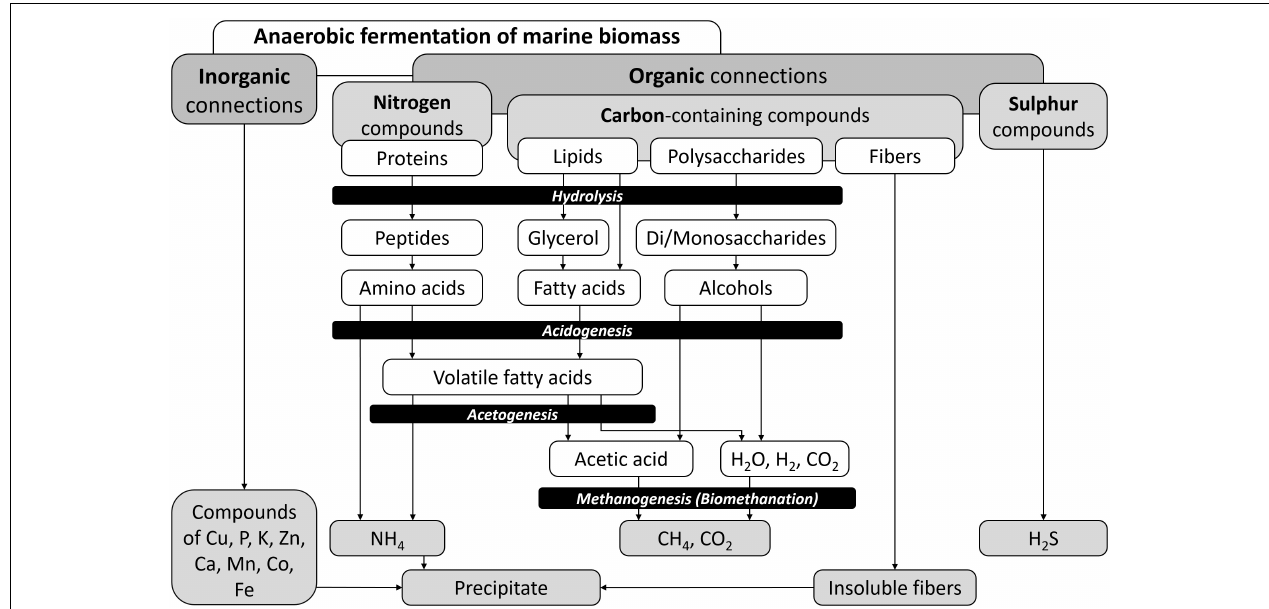
FIGURE 8 | Schematic overview of the anaerobic fermentation of marine biomass, indicating organic and inorganic connections, the main chemical transformation of compounds and resulting intermediate and final